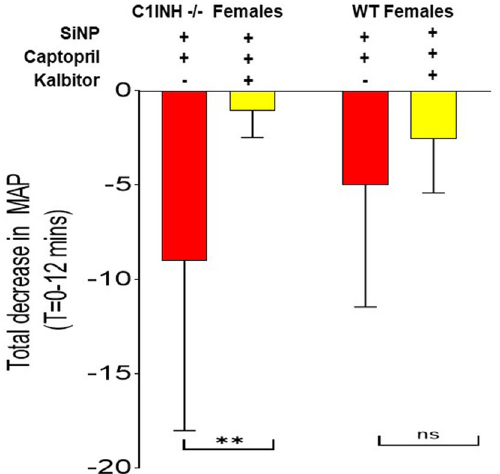
Figure 3. The Serping1−/− murine model is more sensitive than C57BL6 WT mice for assessing treatment of acute HAE-like attacks. Comparison of the integrated effect size, as per the Materials and Methods, of ecallantide treatment of SiNP-induced blood pressure drops in Serping1−/− (n = 18) and WTC57Bl6/J female mice (n = 9). There is significant amelioration of SiNP-induced MAP decrease with ecallantide treatment in Serping1−/− females (P = 0.01) as compared to the C57Bl6 females (NS, P = 0.86). Assessment of the differences between groups of treatments were performed using 2-way Analysis of Variance (ANOVA) with Bonferroni’s post-hoc test (used to determine the significance of mean MAP change of all groups against each other) with *P < 0.02; NS = non-significant. Data are expressed as mean ± SD.